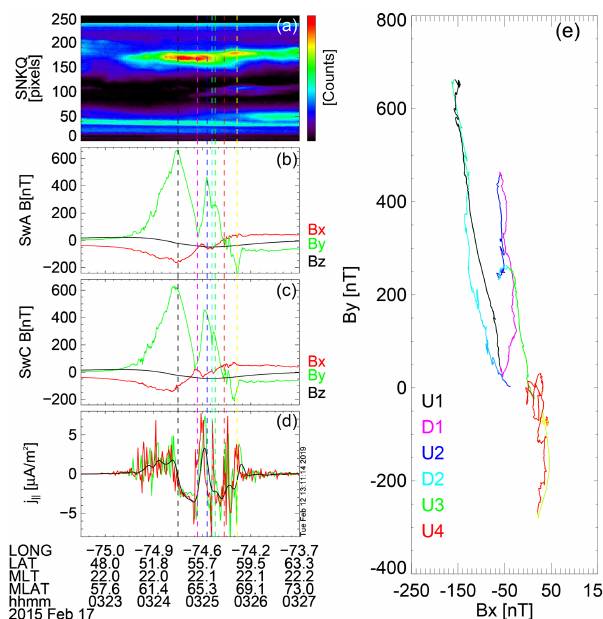
Figure 4. (a) Keogram from SNKQ station; (b–c) magnetic field perturbation from SwA and SwC. (d) Single-spacecraft FAC den- sity estimated by the FD method (L2 product) on SwA (green) and SwC (red); the FAC density estimate based on the two-spacecraft FD method (L2 product) is shown by the black line. The verti- cal dashed lines indicate the beginnings of various FAC elements. (e) Hodogram representation of B ⊥ . The hodogram is first repre- sented in a rainbow color scale (blue to red) on which we superpose a layer of identified FAC intervals using discrete colors associated with the labels. For each FAC segment we use the same color as in panels (a–d) to indicate the beginning of the respective FAC el- ement. The U and D labels indicate upward and downward FACs with the same color